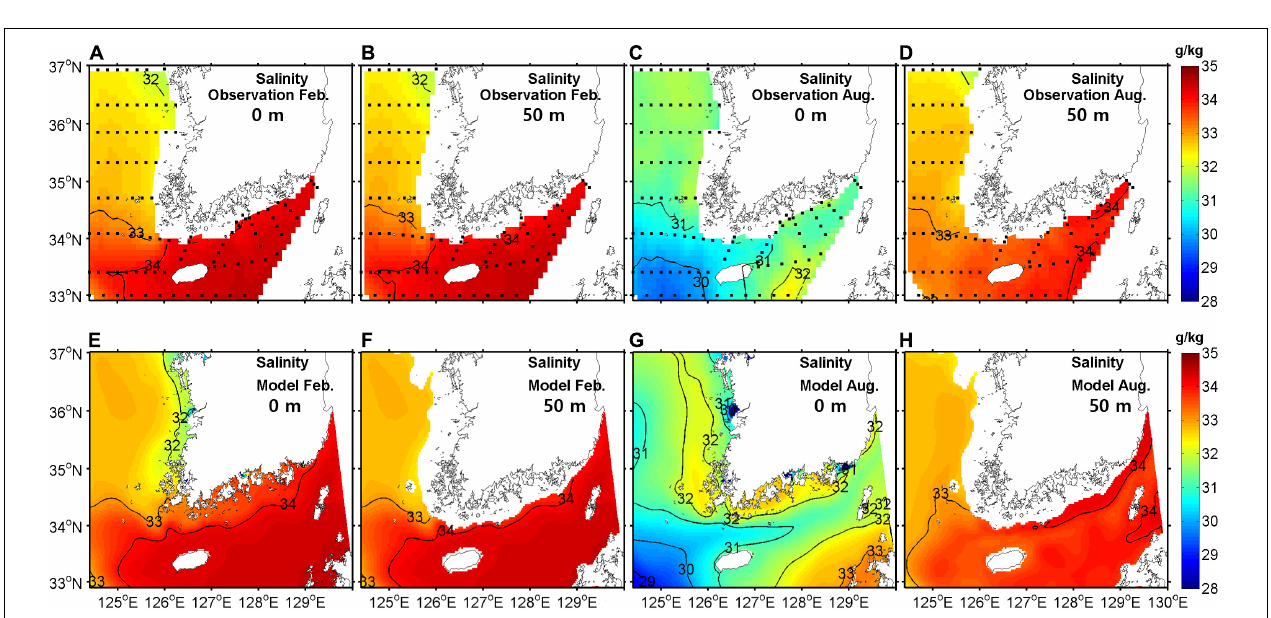
FIGURE 4 | Horizontal distribution of temperature from observations (upper) and model outputs (lower) at the surface (A,C,E,G) and at a depth of 50 m (B,D,F,H) in February (A,B,E,F) and August (C,D,G,H) averaged for the period 2006–2019 (units are ◦ C).